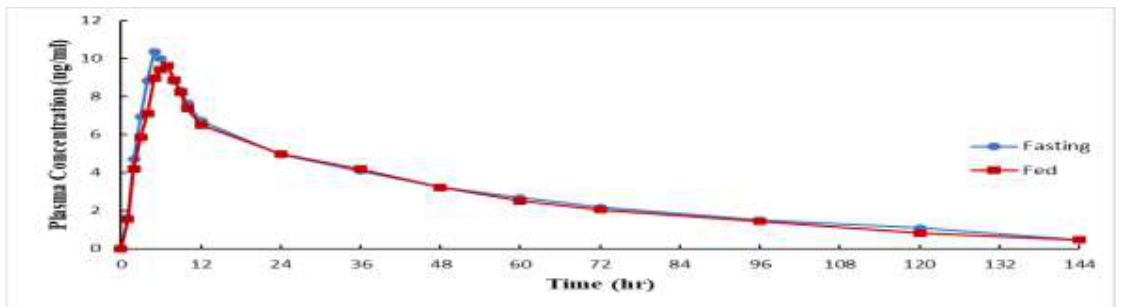
Figure 3. Comparison of mean plasma concentration-time profiles (t=0-144 hr) of fluoxetine after administering fluoxetine 20 mg capsules to healthy adult Arabic subjects under fasting and fed